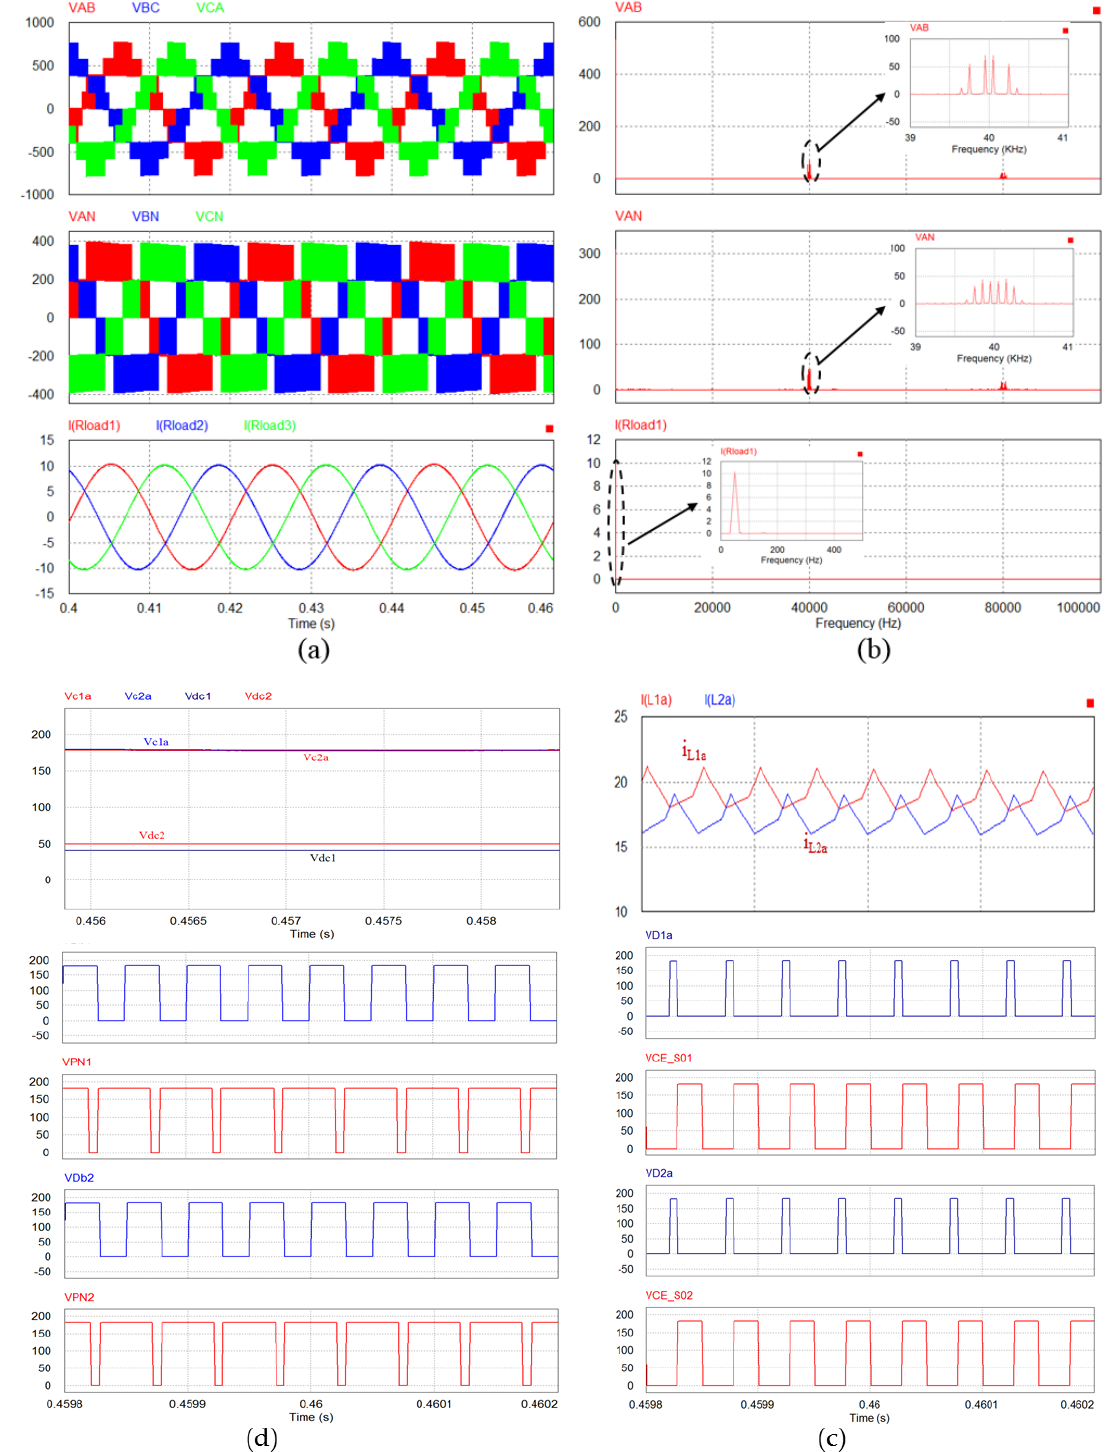
Figure 8. Simulation results for the CHB-qSBI when the input voltage V dc 1 = 40 V and V dc 2 = 50 V. From top to bottom: ( a ) output line-to-line voltages, output phase voltages, and phase currents; ( b ) harmonic spectrum of output line-to-line voltages, harmonic spectrum of output phase voltages, and harmonic spectrum of phase currents; ( c ) input voltages, capacitors C 1 and C 2 voltages, diodes D b1 and D b2 voltages, and DC-link voltages; and ( d ) inductor currents, diode D a 1 voltage, switch S 01 voltage, diode D a 2 voltage, and switch S 02 voltage of phase A.